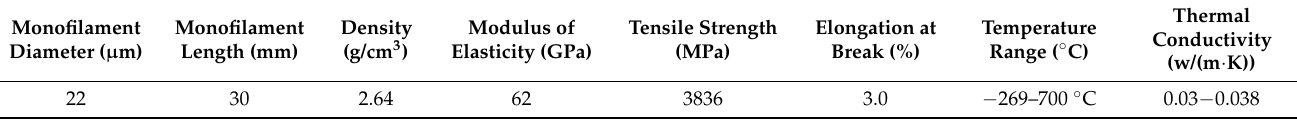
Table 1. Basalt fiber performance index.